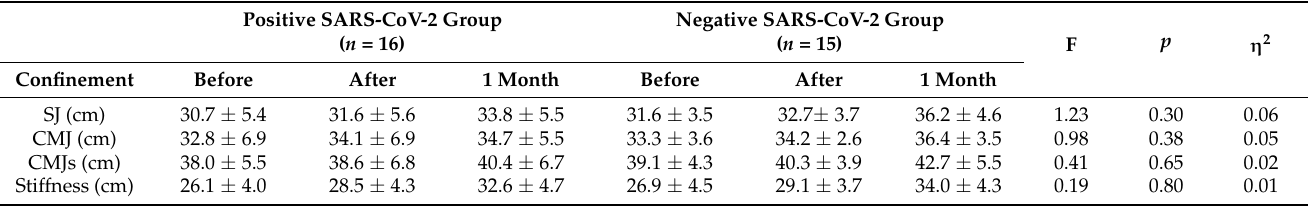
Table 3. Evolution of jump parameters in the positive and the negative SARS-CoV-2 groups (ANOVA between groups at each time-point: 3 time-points × 2 groups).